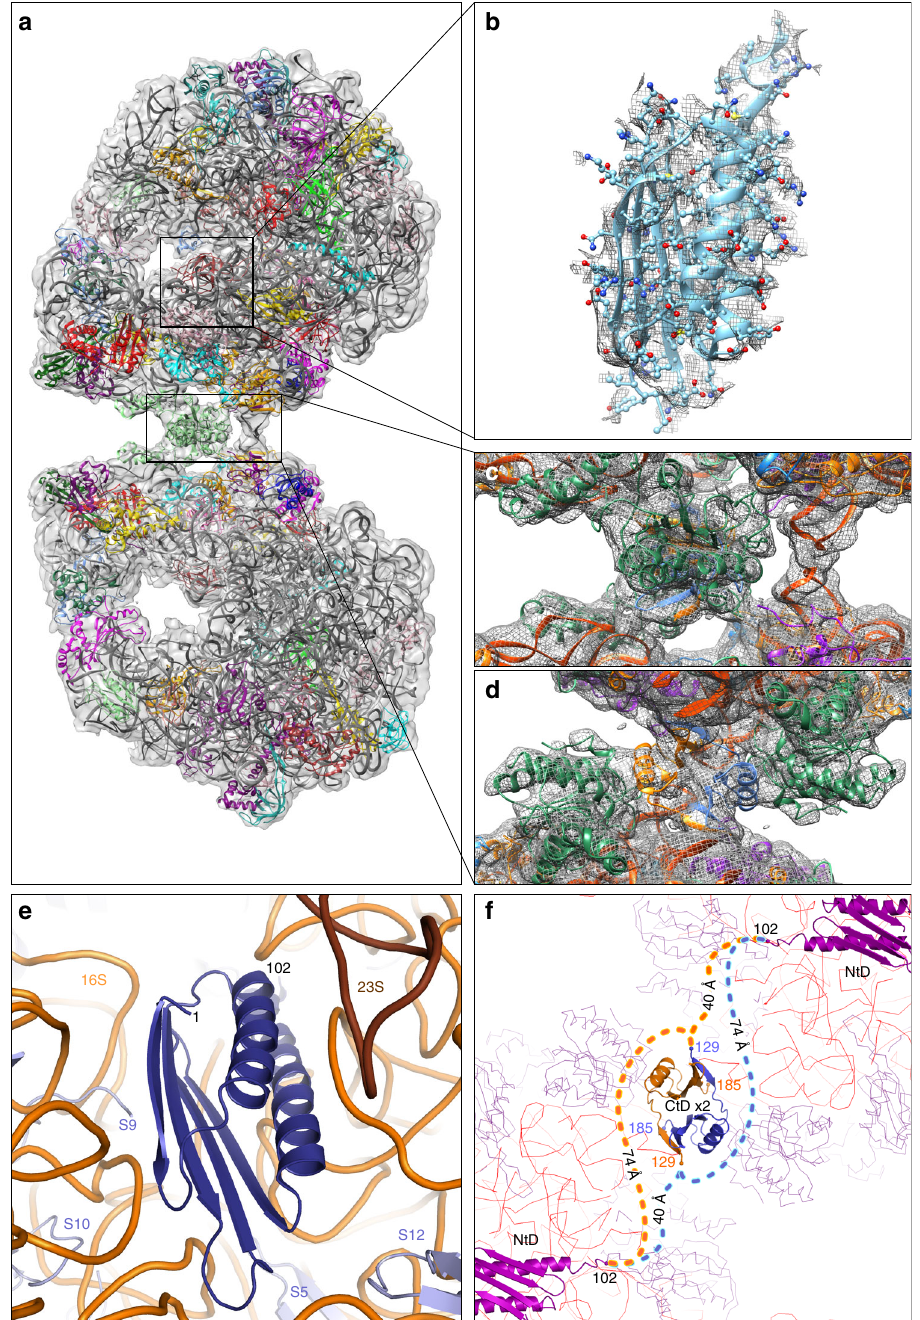
Fig. 2 Location of the N- and C-terminal domain of HPF long . The extra, unmodeled densities in the map, indicated by the boxes of a , correspond to HPF long N-terminal domain ( b and Supplementary Movie 1) and C-terminal domain ( c , d and in Supplementary Movie 2; colored gold and blue ). d has been rotated 90° with respect to a , c , showing the dimeric interaction of the C-terminal domains. e The surrounding proteins ( steel blue ) and RNA ( orange ) of the N- terminal domain. f The linking of the distant N- and C-terminal domains (NtD and CtD) is shown schematically. Their respective locations in the dimer are clari fi ed by the surrounding ribosomal proteins ( purple lines ) and 16S rRNA ( red lines